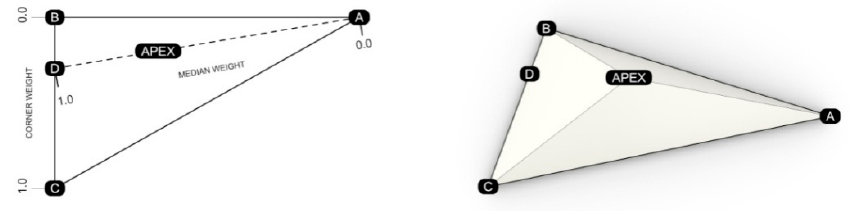
Figure 11. Apex point and corner-weight and median-weight parameters .